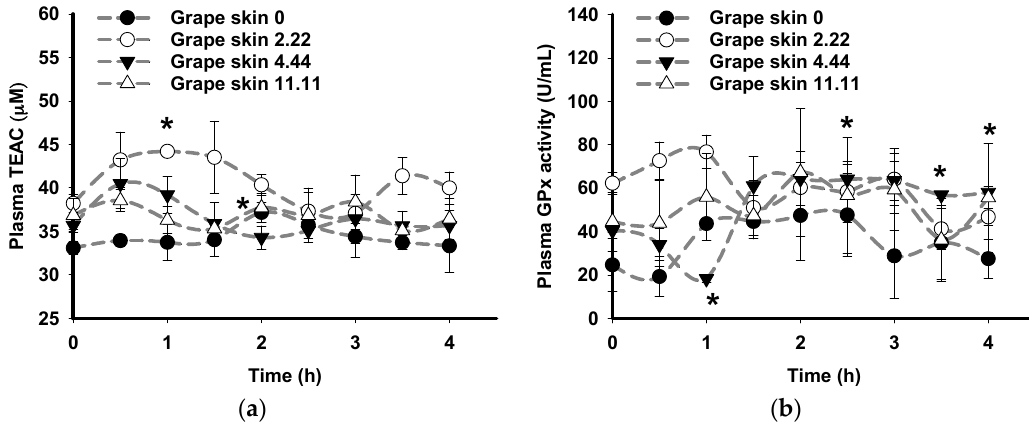
Figure 3. Effects of oral consumption of grape skin extract on the plasma antioxidant status of pigs. Pigs consumed grape skin extract at four doses in mg gallic acid equivalent/kg body weight: 0 (black circle), 2.22 (white circle), 4.44 (black triangle), and 11.11 (white triangle). Plasma antioxidant status was measured as: ( a ) plasma Trolox equivalent antioxidant capacity (TEAC); and ( b ) plasma glutathione peroxidase (GPx) activiy. Data points labelled “*” are significantly different from baseline at time 0 ( p ≤ 0.05, Tukey’s test). Results represent the mean and error bars represent standard error of the mean ( N = 3).